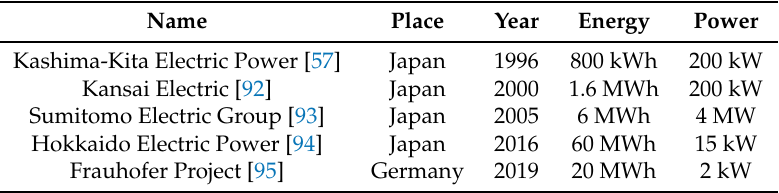
Table 5. Main existing installations of VRFBs in the